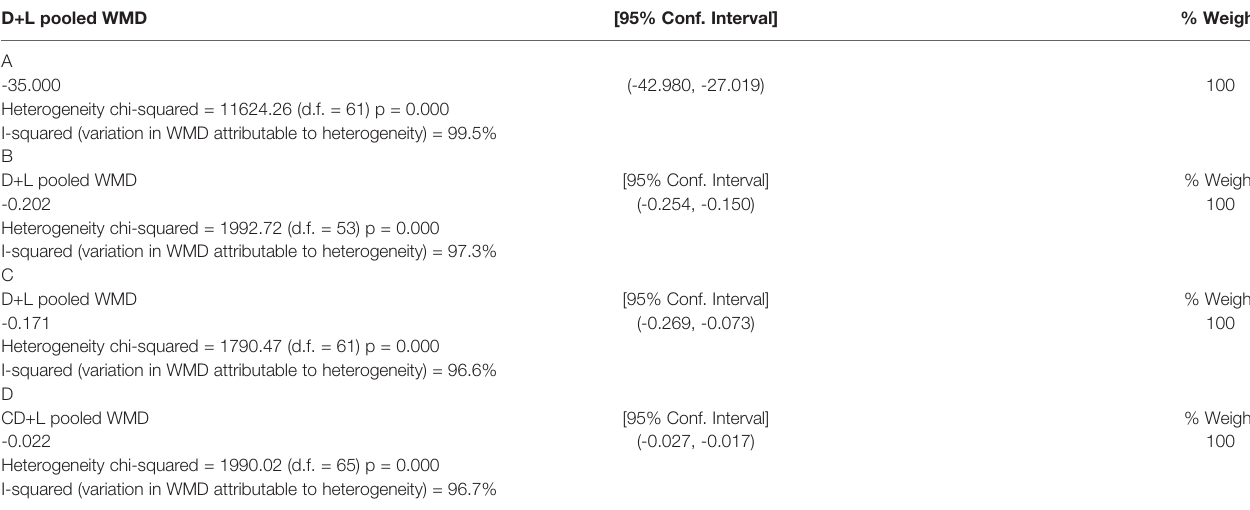
TABLE 3 | Data of overall